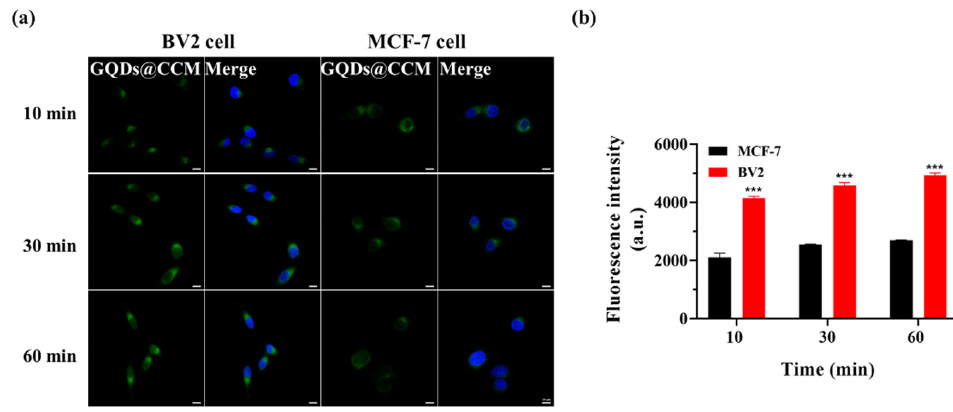
Figure 7. Homologous targeting of GQDs@CCM. ( a ) CLSM images of BV2 and MCF-7 cells incu- bated with GQDs@CCM at a GQDs concentration of 200 µ g/mL for different time periods. Scale bar = 10 µ m. ( b ) Quantitative analysis of cell uptake by FCM in different time periods. The differences among groups were determined by a one-way ANOVA analysis followed by the Tukey’s post-test: *** p < 0.001.